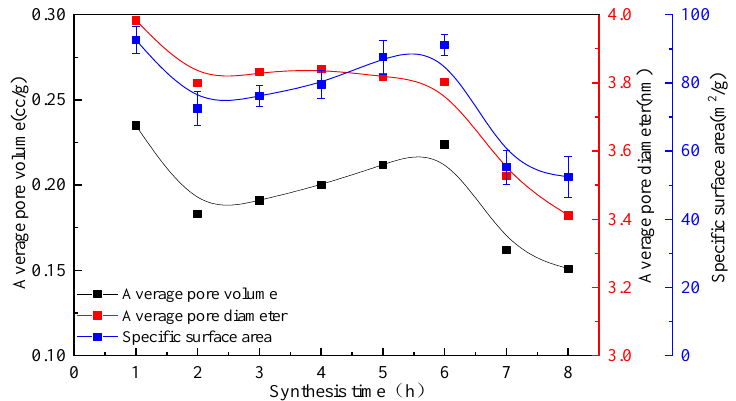
Figure 3. Change in APV, APD, and SSA of the hydrothermal synthesis with an increase in hydrothermal synthesis time.